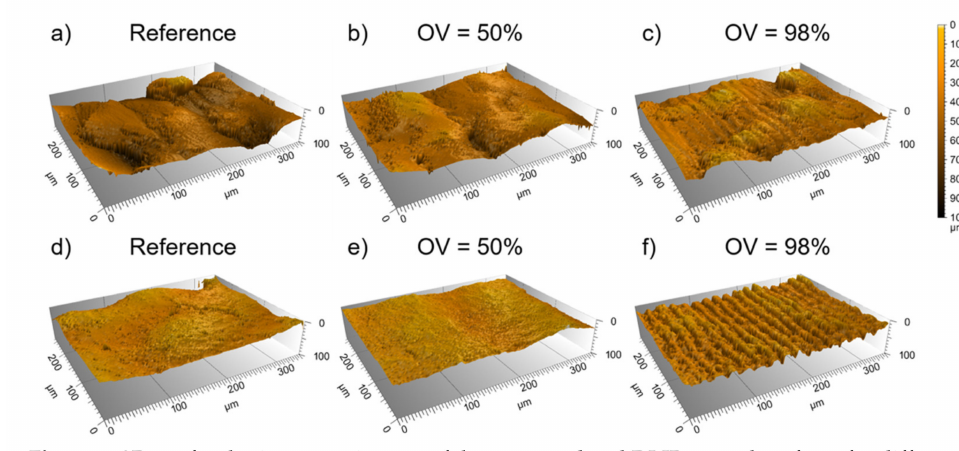
Figure 3. 3D confocal microscope images of the untreated and DLIP treated surfaces for different pulse overlaps (OV = 50% and 98%) for Ti64 ( a – c ) and Scalmalloy ® ( d – f )